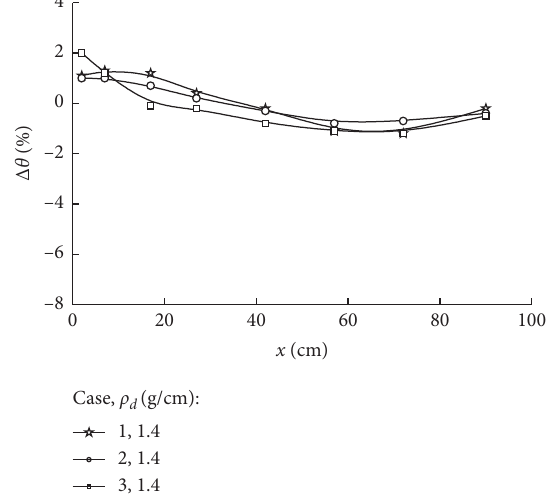
Figure 6: The moisture content variations caused by cooling in the different cases ( t �